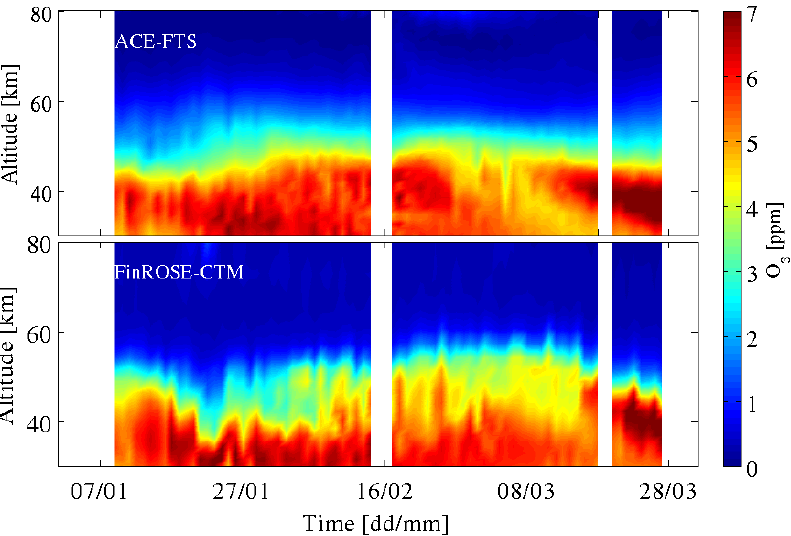
Fig. 8. ACE-FTS (top) and FinROSE-CTM (bottom) ozone time series in ppm as a function of altitude for early 2009 in ACE-FTS measure- ment